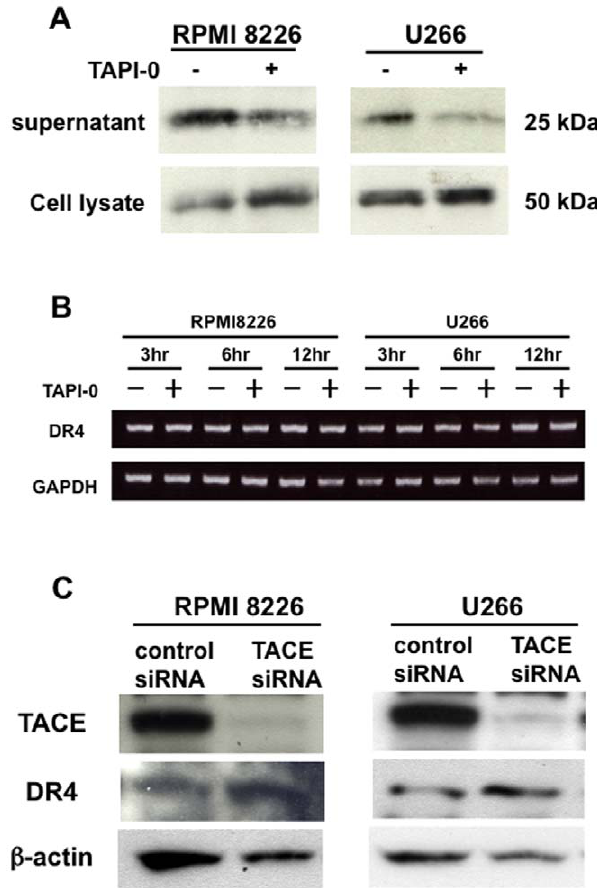
Figure 3. TACE is responsible for ectodomain shedding of DR4. A. Cell lysates and culture supernatants were harvested after culturing RPMI8226 and U266 cells for 48 hours in the absence or presence of TAPI-0 at 10 m M. DR4 immunoreactivity was analyzed by immunoblot- ing with an antibody against an DR4 extracellular domain. B. RPMI8226 and U266 cells were cultured for different hours as indicated in the absence or presence of TAPI-0 at 10 m M. DR4 mRNA expression was analysed by RT-PCR in RPMI8226 and U266 cells. GAPDH was used for quantity normalisation. C. RPMI8226 and U266 cells seeded in 24-well plates were transfected with TACE or control scrambled siRNA. After culturing for 48 hours, cell lysates were harvested. DR4 immunoreac- tivity was analysed by immunobloting. b -actin was used as a loading control.